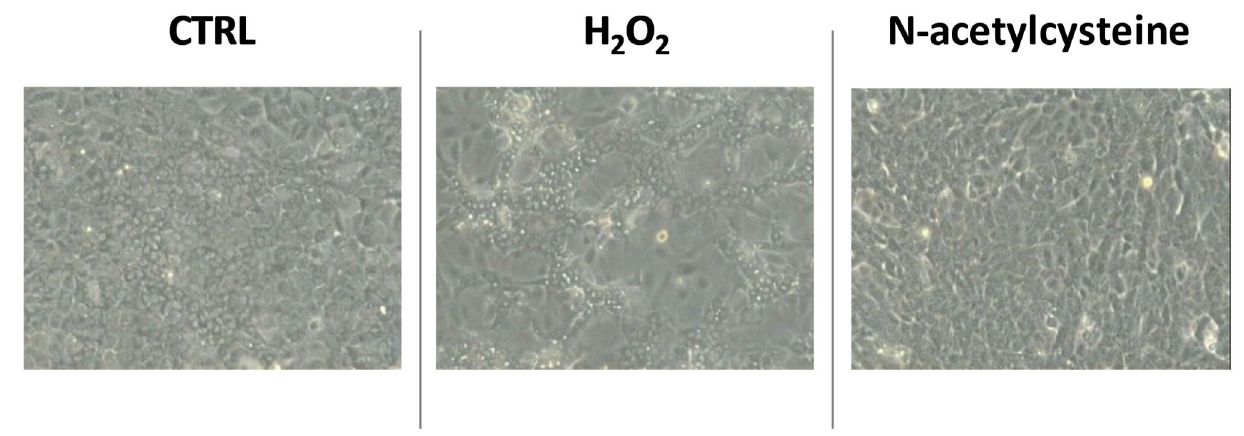
Figure 2. Representative microscopic images of confluent HepaRG cells exposed to vehicle (CTRL), 100 μ M H 2 O 2 , or 1 mM N ‐ acetylcysteine every 24 h for 5 days.